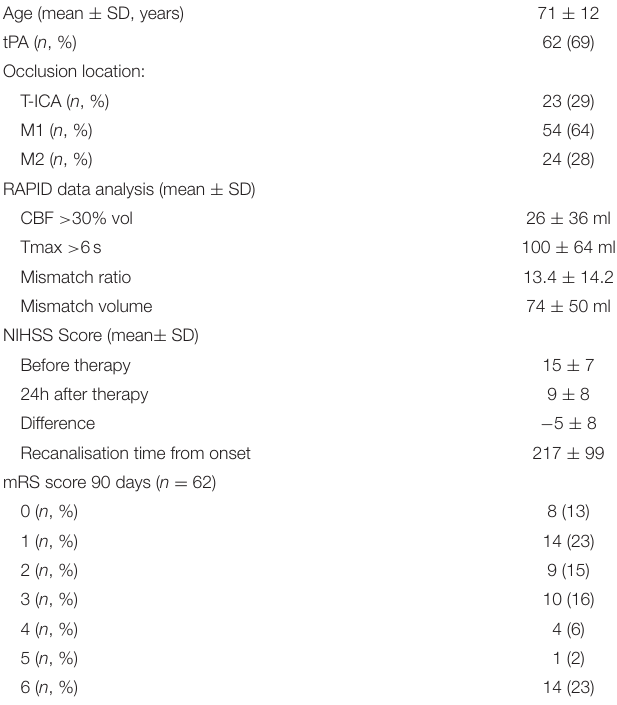
TABLE 1 | Clinical